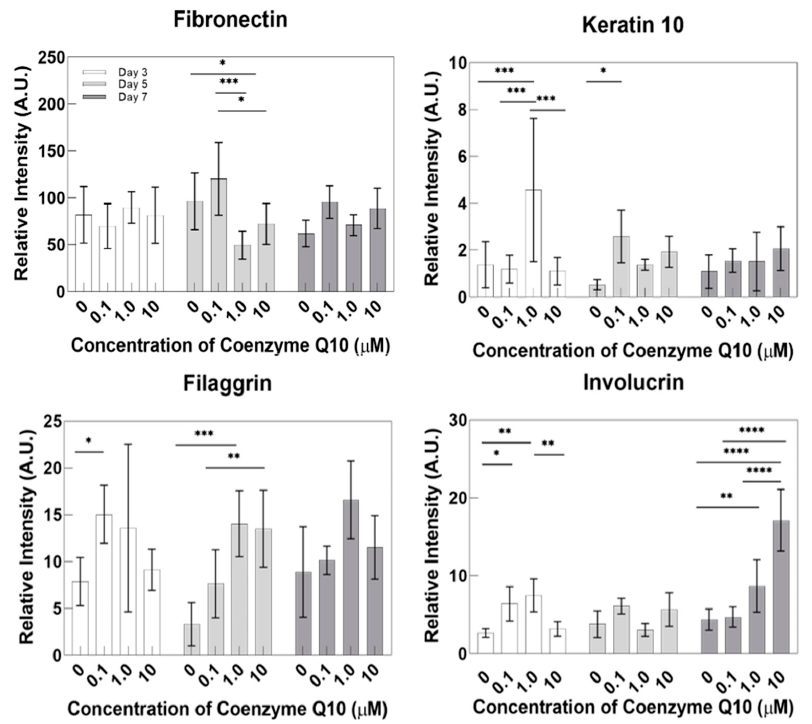
Figure 10. Quantitative analysis of protein expression for fibronectin, keratin 10, filaggrin, and involucrin from the immunohistochemistry stained images ( p -value: * < 0.05, ** < 0.01, *** < 0.001, and **** < 0.0001).